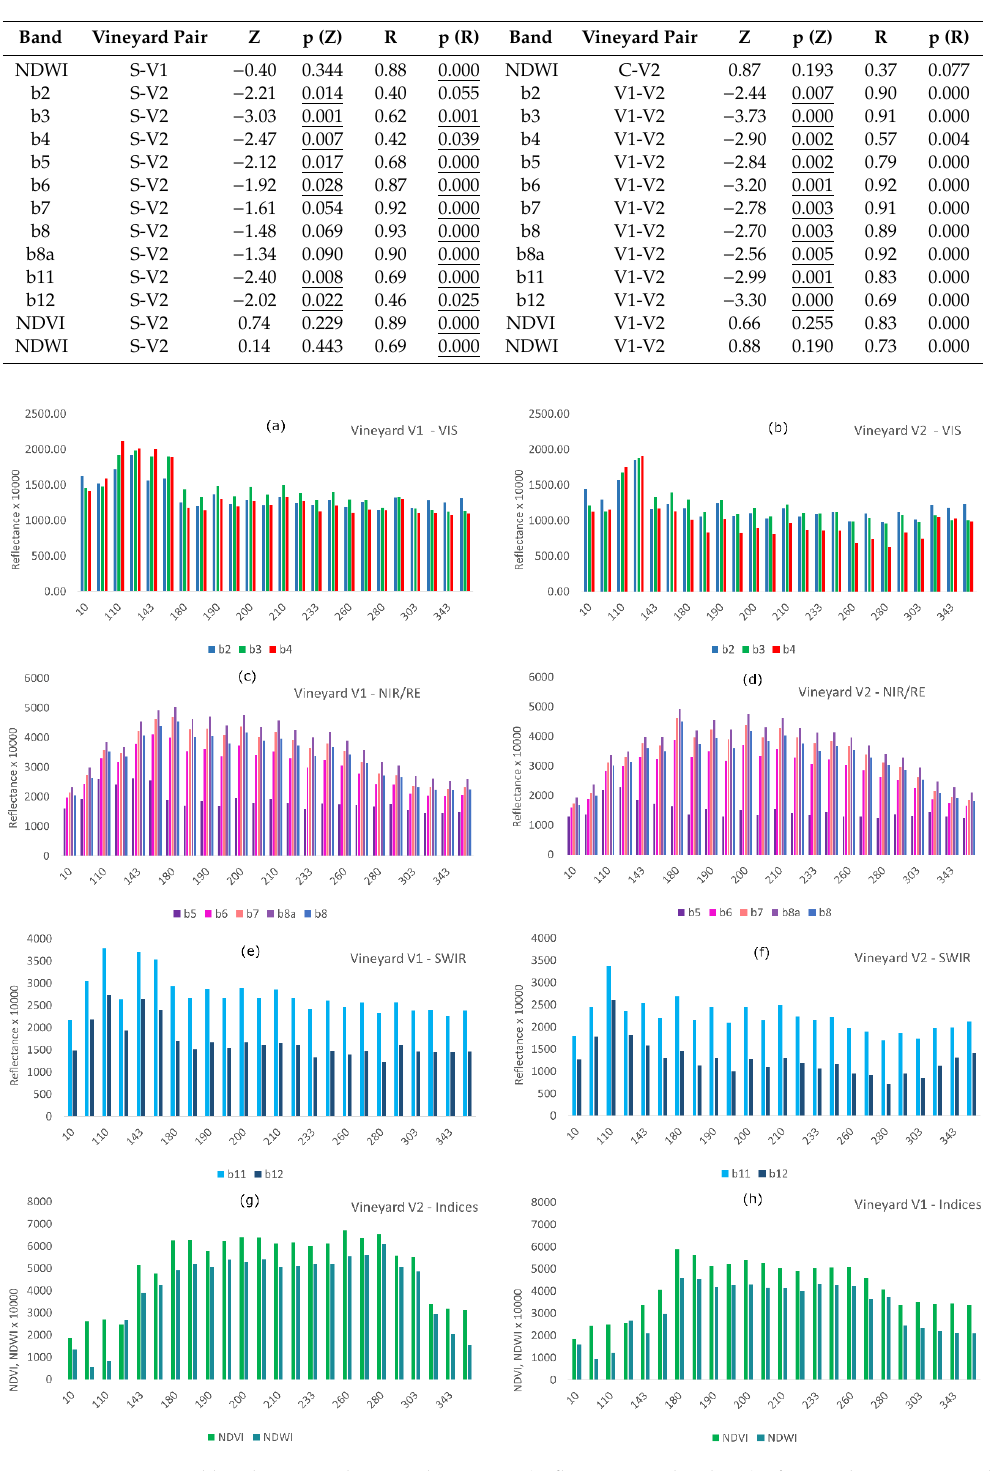
Figure 6. At-vineyard level averaged spectral response (reflectance and indices) of V1 and V2 uncovered vineyards along the year (2016). Values were computed at plot level for each date for all the considered S2 bands and for NDVI and NDWI indices. Spectral profiles of the two vineyards were quite similar. Figures ( a , c , e ) refer to vineyard V1 and show temporal trends of visible, NIR and SWIR bands, respectively. Similarly, figures ( b , d , f ) refer to vineyard V2 and show temporal trends of visible, NIR and SWIR bands, respectively. Figure ( g , h ) show temporal trends of spectral indices (NDVI, NDWI) for vineyard V2 and V1 respectively.